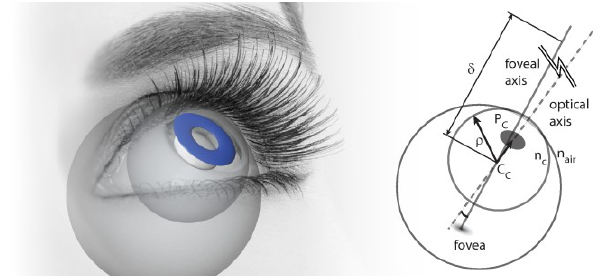
Figure 3. The simplified model of the human eye. The pu- pil is actually a hole in the iris, allowing light to enter the retina. The corneal surface can be modeled as a sphere partly embedded in the eye. P c and C c refer to centers of the pupil and corneal sphere through which the optical axis traverses. The radius of the corneal sphere is de- noted with ρ. n c and n air refer to refractive indices of cor- nea and air. Fovea is the spot on the retina with the high- est density of photoreceptors. The axis that (approxi- mately) traverses the gaze point, C c , and the fovea is called the foveal axis (to be precise, the visual axis and the optic axis intersect at the nodal point of the eye which is within 1 mm of the cornea center (Guestrin and Eizenman, 2006)). δ is the gaze distance along the foveal axis between C c and gaze